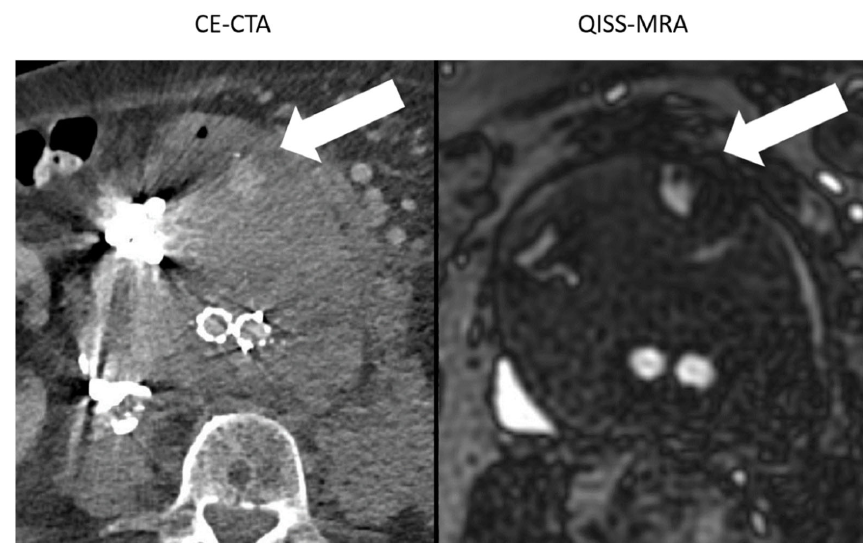
Figure 4. Comparison between the image quality of CE-CTA and 2D non-CE radial QISS-MRA in the presence of metallic substances. In CE-CTA, metal artifacts caused by embolization material impair the outlining of the aneurysm sac. Therefore, the adjacent type II endoleak on the hyperdense metallic artifacts can be overlooked (white arrow). In contrast, both aneurysm sac and endoleak were clearly visualized using QISS-MRA (white arrow).